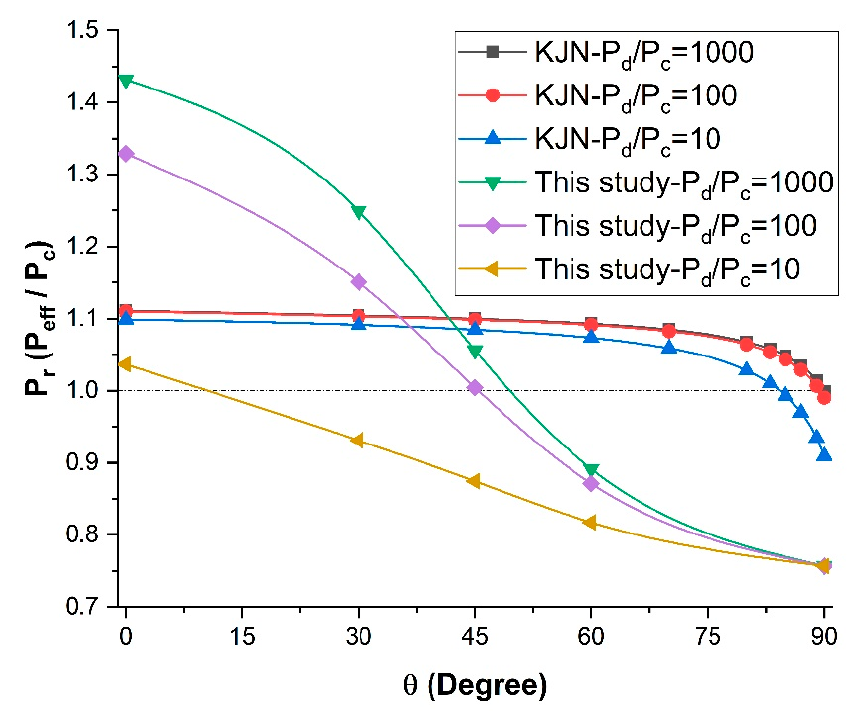
Figure 10. Comparison of the relative permeability predicted by the numerical simulations with the KJN model as a function of the nanotube orientation for three permeability ratios at ϕ = 0.1 and α = 10.